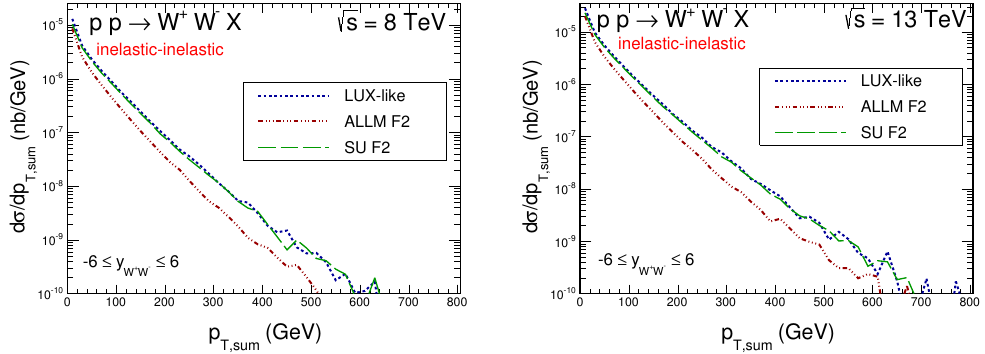
Figure 5 . Transverse momentum distribution of W + W (cid:0) bosons for di(cid:11)erent structure functions: LUX-like, ALLM97, SU. The left panel shows results for p results for s = 13